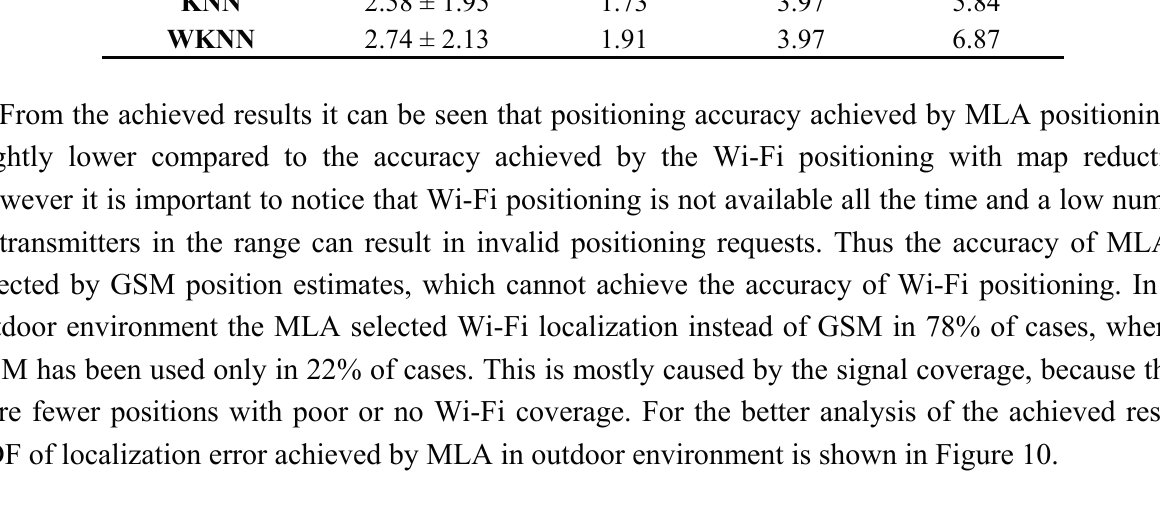
Figure 10. CDF of localization error in the outdoor